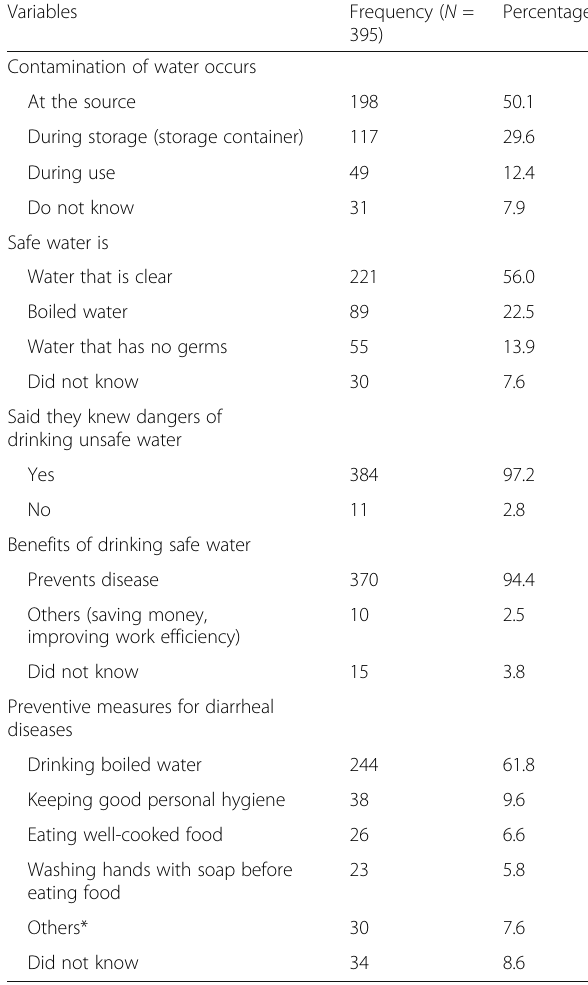
Table 4 Knowledge on water safety and its